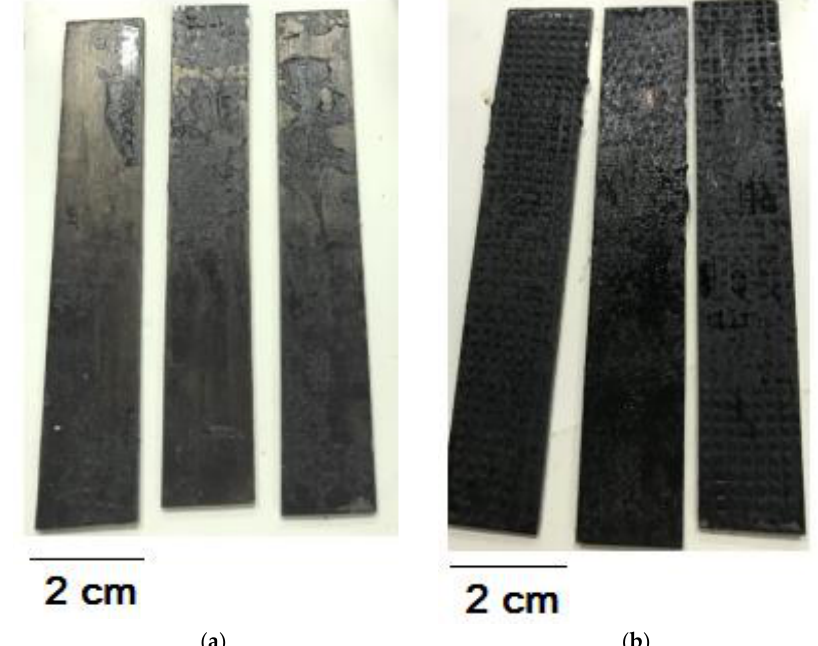
Figure 9. Photographs of metal-polymer (BP) adhesive joints: ( a ) nonmodified steel, ( b ) steel modified with the BTA solution. The sample dimensions are 100 mm × 20 mm.